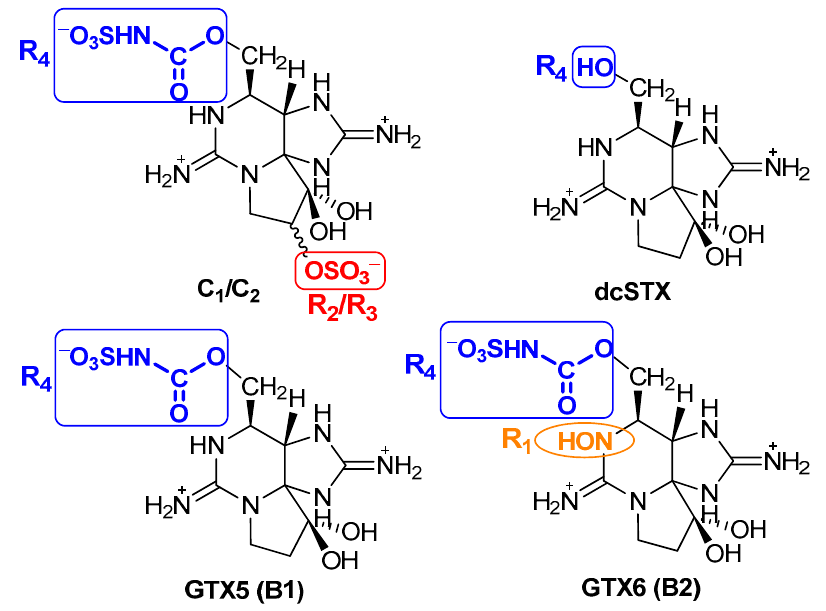
Figure 7. Molecular structures of some PST, under acidic conditions [2].